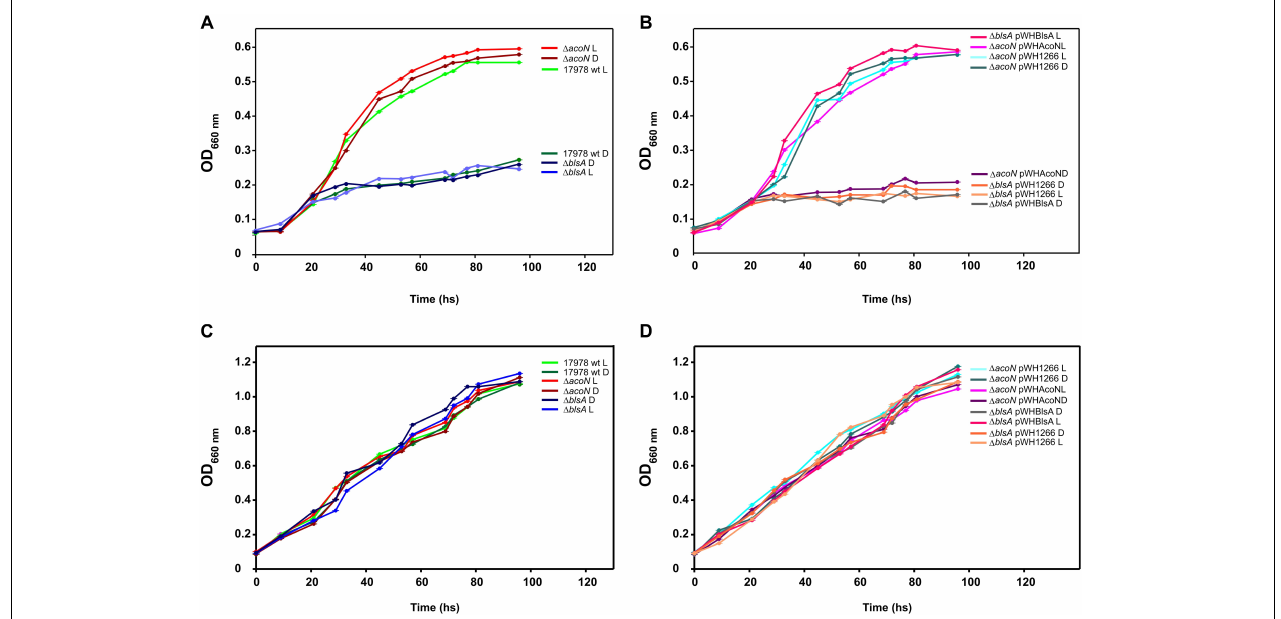
FIGURE 4 | Light modulates acetoin catabolism at moderate temperatures in A. baumannii ATCC 17978. (A,B) Growth curves in M9 minimal medium supplemented with acetoin 5 mM as sole carbon source of A. baumannii ATCC 17978 wild-type and derivative strains, incubated stagnantly at 23 ◦ C under blue light (L) or in the dark (D). (C,D) Growth curves in LB medium of A. baumannii ATCC 17978 wild-type and derivative strains incubated stagnantly at 23 ◦ C under blue light (L) or in the dark (D). Growth was measured by determining the optical density at 660 nm. The experiments were performed at least in triplicate, including three replicates for each strain at each condition. Representative results are